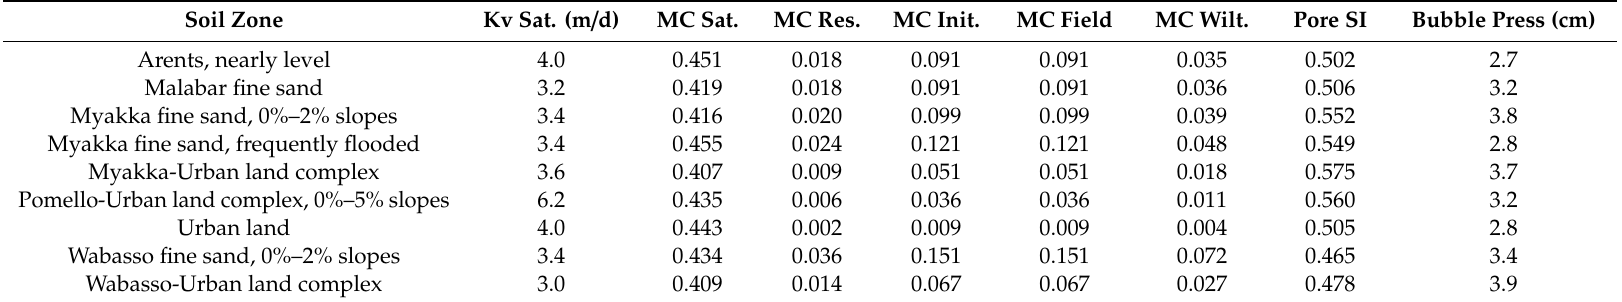
Table 1. Green–Ampt soil parameters from Natural Resource Conservation Service (NRCS) data base. Soil Zone Kv Sat. (m / d)